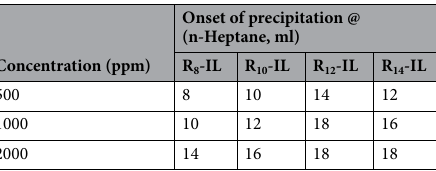
Table 8. Effect of different concentrations of the prepared dispersants on the onset precipitation point of asphaltene.